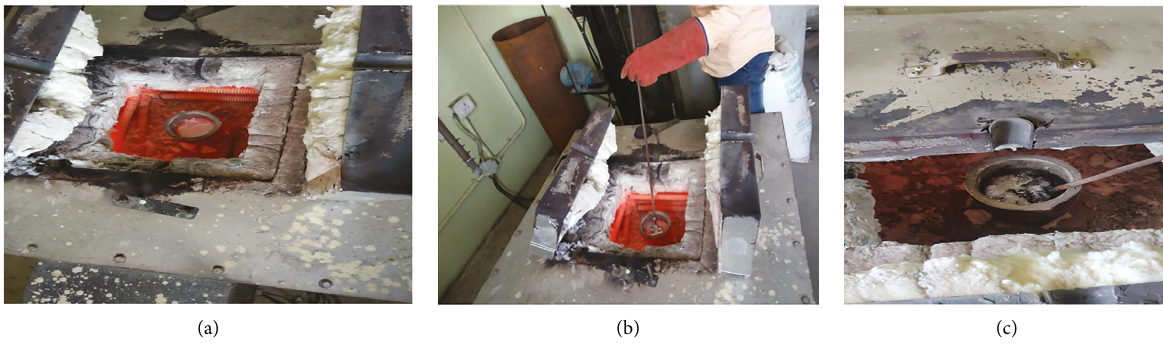
Figure 10: (a) Crucible in furnace. (b) Manual stirring. (c) Stirring of molten melt.